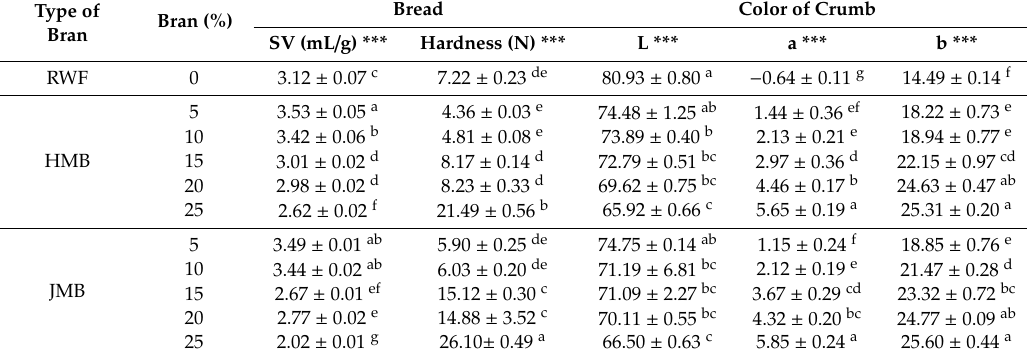
Table 4. Specific volume (SV), crumb hardness, and color characteristics of breads made with flour substituted with HMB or JMB at various levels (0%, 5%, 10%, 15%, 20%, and 25%). Bread Color of Crumb Type of Bran (%) Bran a *** b ***